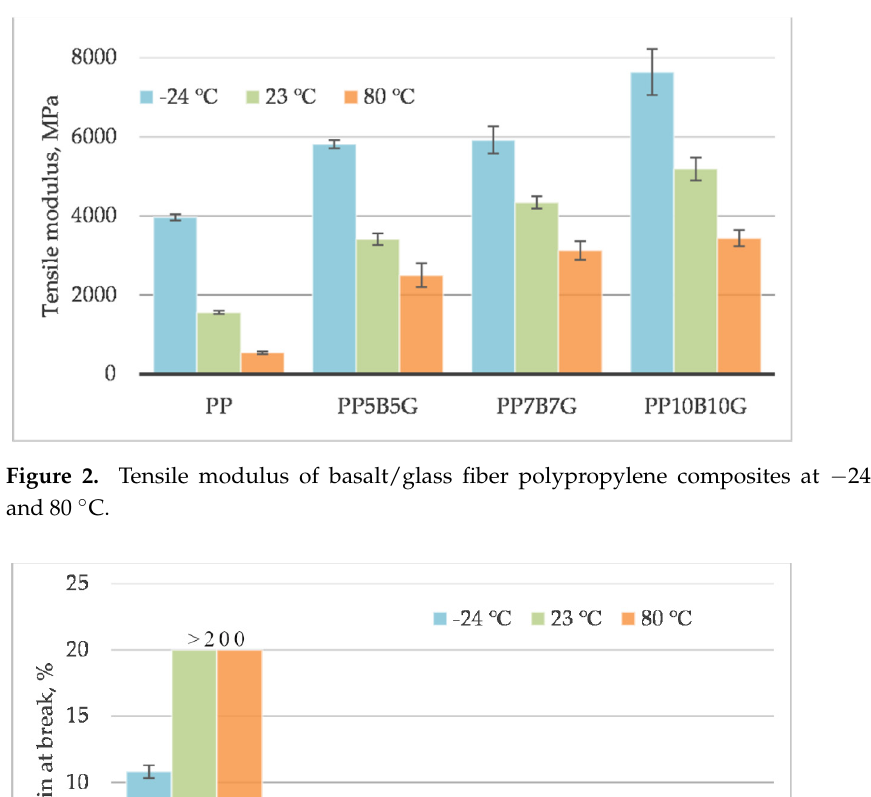
Figure 1. Tensile strength of basalt/glass fiber polypropylene composites at − 24 °C, 23 °C, and 80 °C .